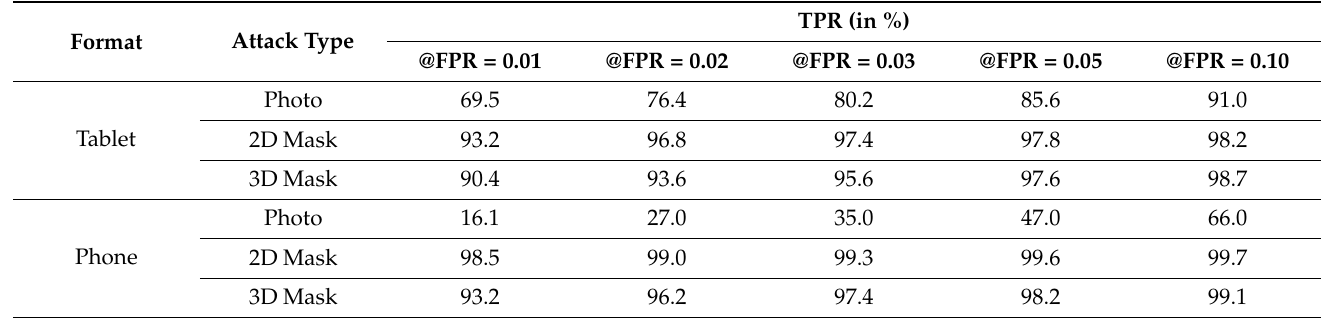
Table 1. TPR at various FPR settings (trajectory: Lines ; duration: 5 s).